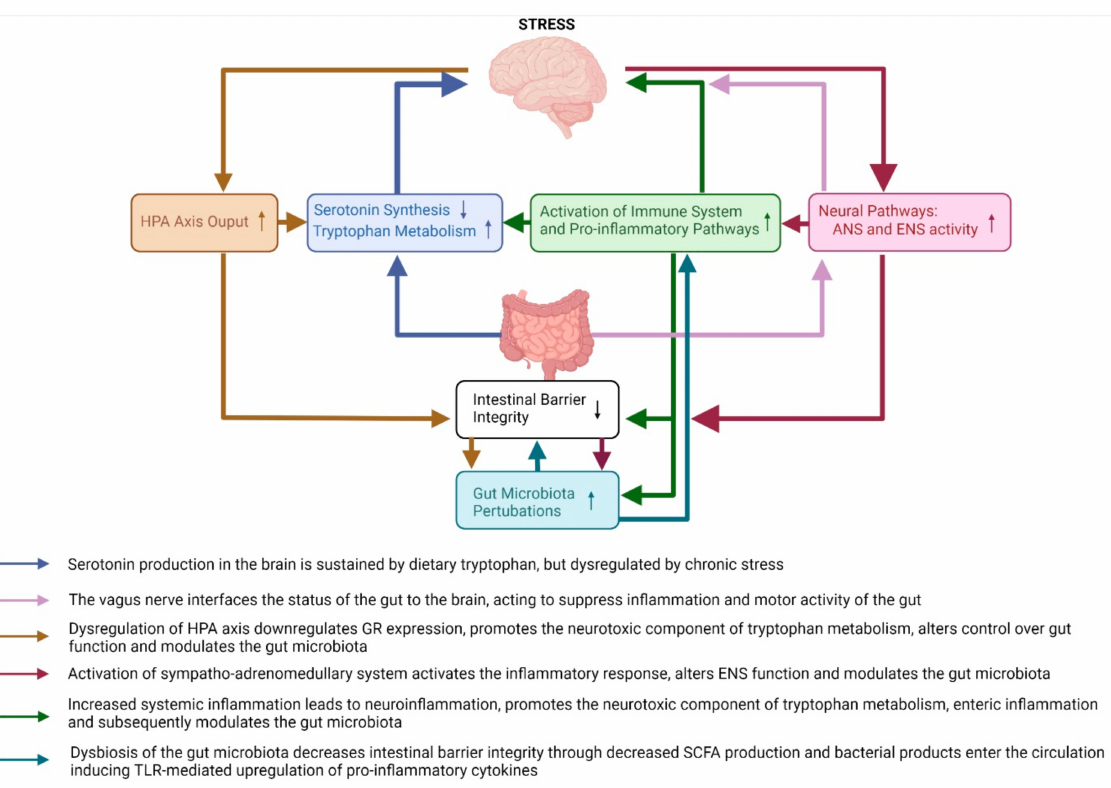
Figure 1. An overview of the major brain-to-gut and gut-to-brain pathways affected by chronic stress in animal models of stress and depression. The pathways affected by chronic stress include the HPA axis, neural pathways, immune system pathways, serotonin and tryptophan pathways, intestinal barrier integrity and gut microbiota pathways. HPA—hypothalamic–pituitary–adrenal axis; ANS—autonomic nervous system; ENS—enteric nervous system; GR—glucocorticoid receptor; SCFA—short chain fatty acids; TLR—toll-like